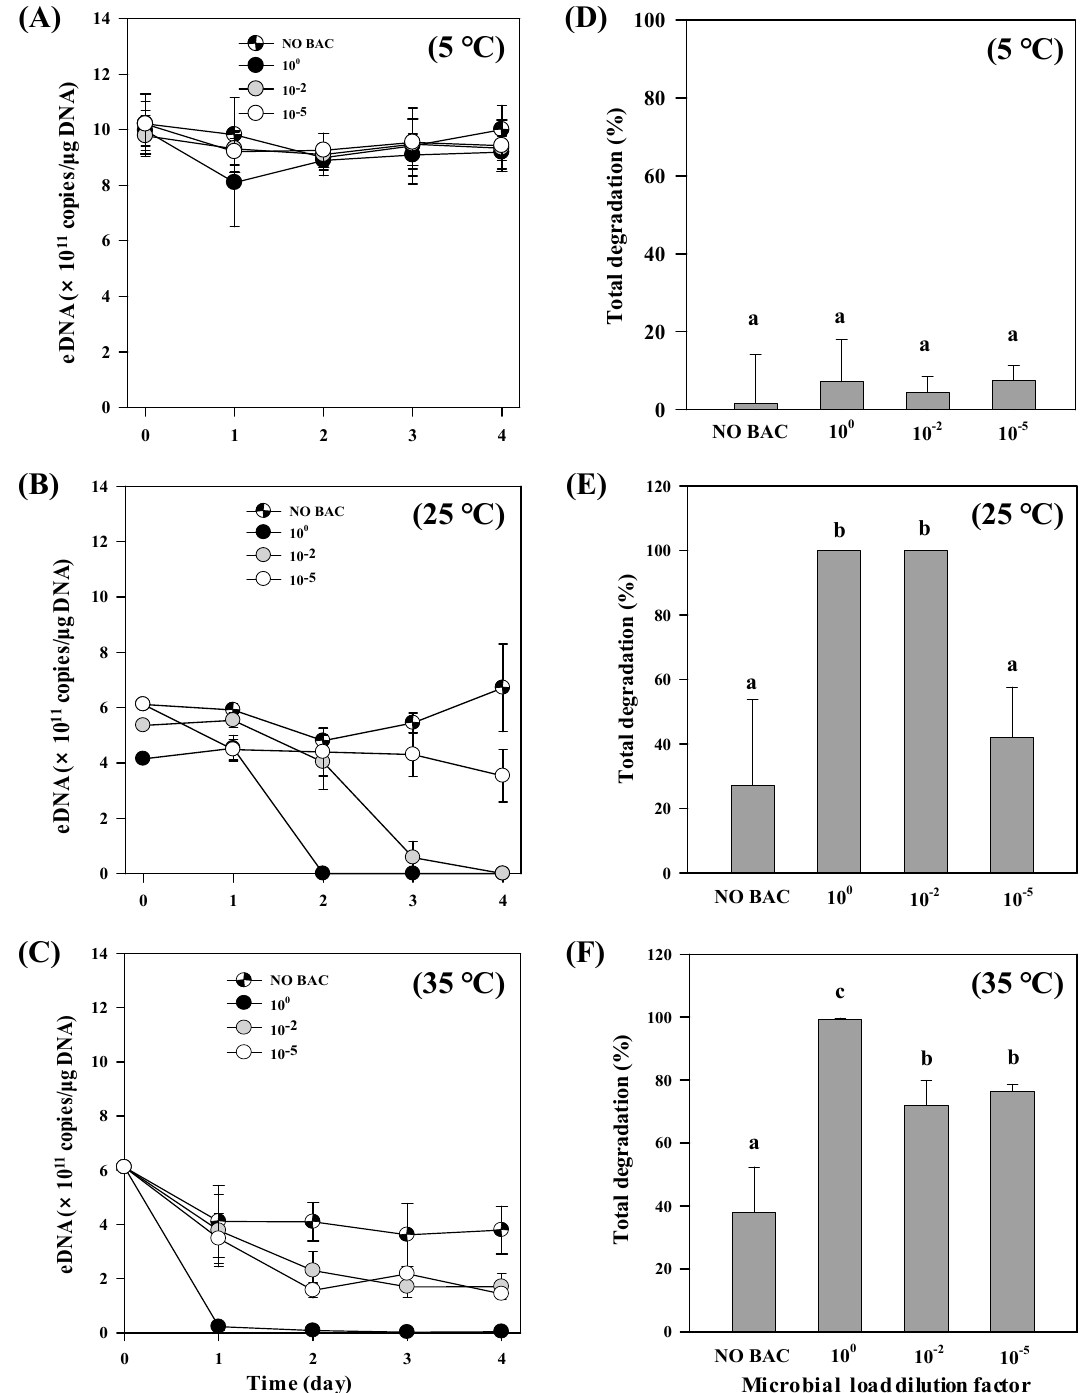
Figure 2. ExDNA concentration in samples exposed to di ff erent bacterial abundance and temperatures. ( A – C ) Changes in exDNA concentration detected under di ff erent bacterial treatments (no bacteria added and diluted bacterial solutions by 10 0 , 10 − 2 , and 10 − 5 -fold) at di ff erent temperatures (5 ◦ C, 25 ◦ C, and 35 ◦ C). Average bacterial abundance before dilutions was 1.6 ± 0.12 × 10 7 cells / mL. ( D – F ) Total exDNA degradation (%) at the end of the experiments (4 days). NO BAC: no bacteria added. Di ff erent letters indicate statistically significant di ff erences defined by p < 0.05 between treatments. Error bars represent the standard deviations among replicates within treatments.